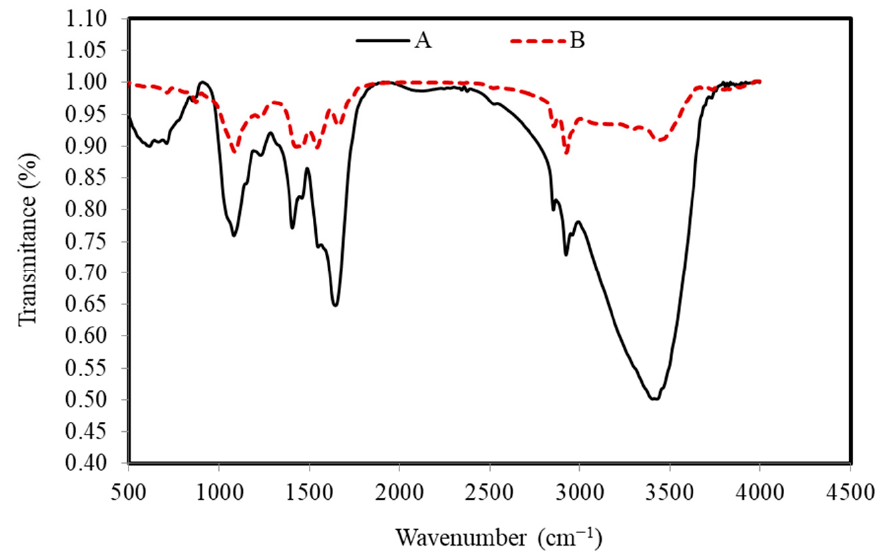
Figure 3. FTIR peaks of the S. costatum adsorbent before (A) and after (B) adsorption of CVD. The wide peaks, which are located at around 3403, 3295, and 3495 cm − 1 , are typically due to adsorbed water and/or the groups of hydroxyl [64]. The bands that existed around 2922 and 2856 cm − 1 correspond to C–H vibrations of methyl and methylene groups.